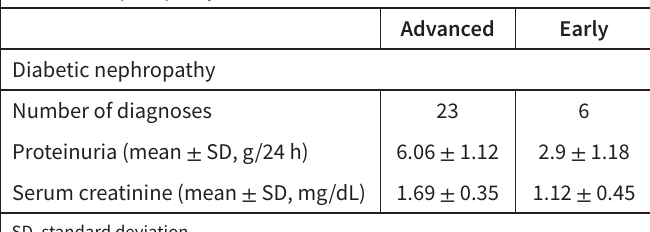
Table 1. Proteinuria and Serum Creatinine in Patients with Diabetic